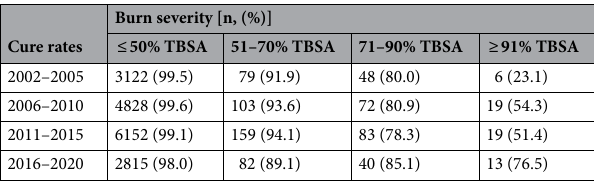
ABSI burn score (score